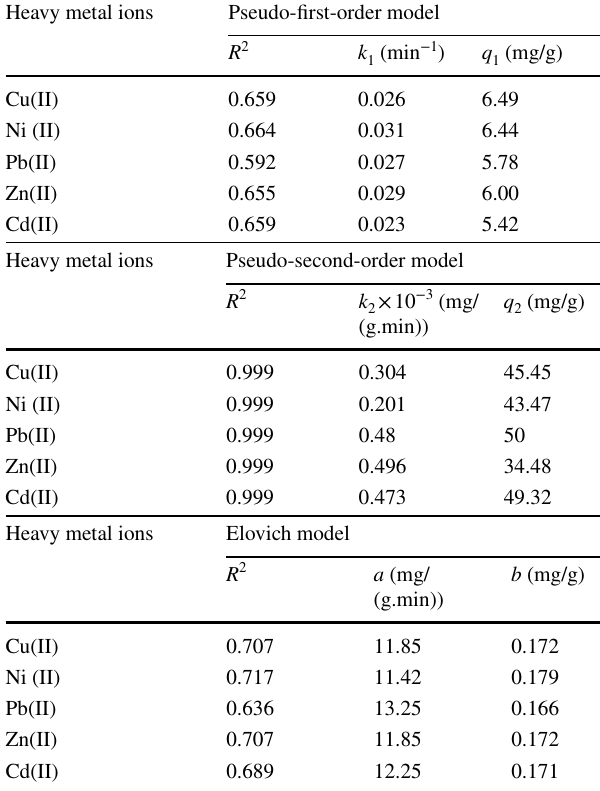
Table 2 Kinetic parameters for the biosorption of heavy metals by Posidonia oceanica fibers Heavy metal ions